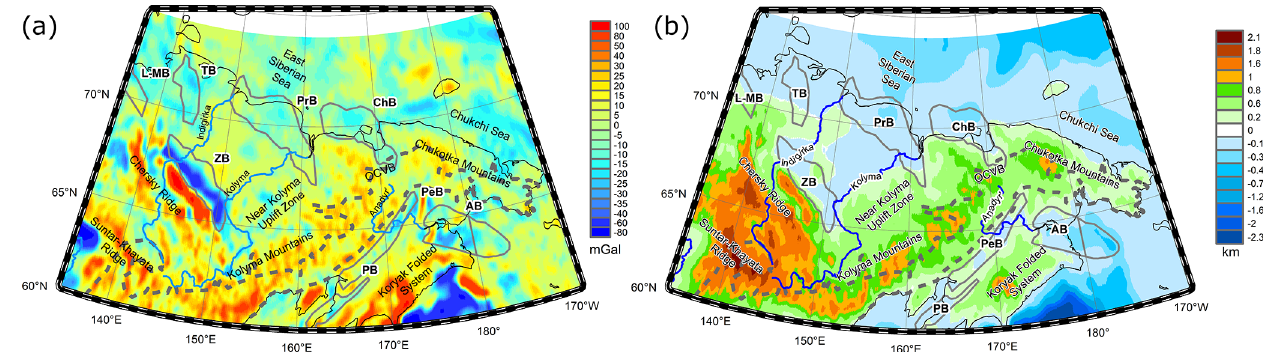
Figure 3. (a) Residual gravity anomalies. (b) Adjusted topography representing a unified surface load with the standard density of topography (2.67g/cm 3 , Eq.